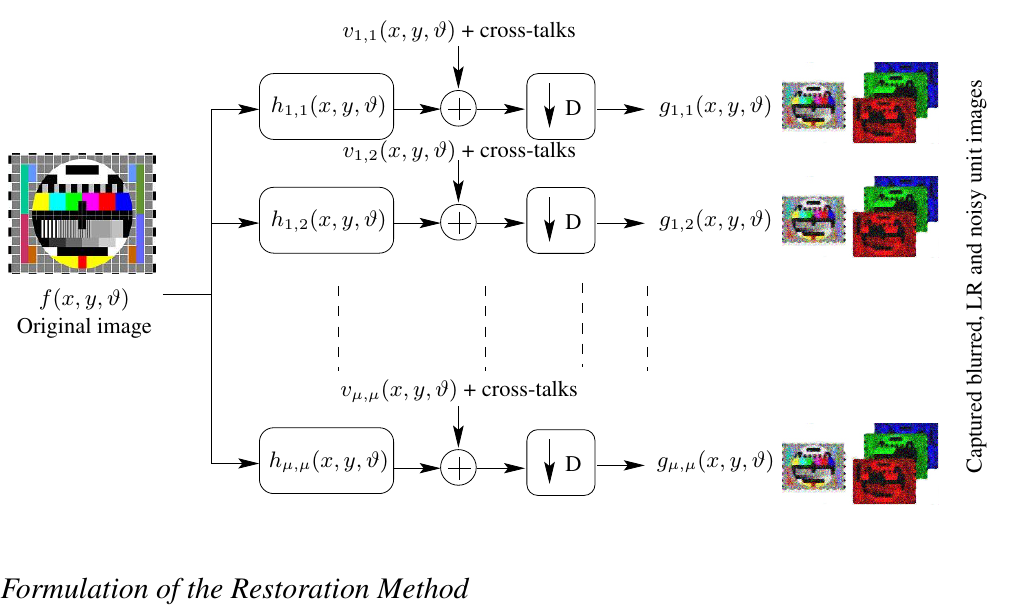
Figure 3. System model for the color TOMBO